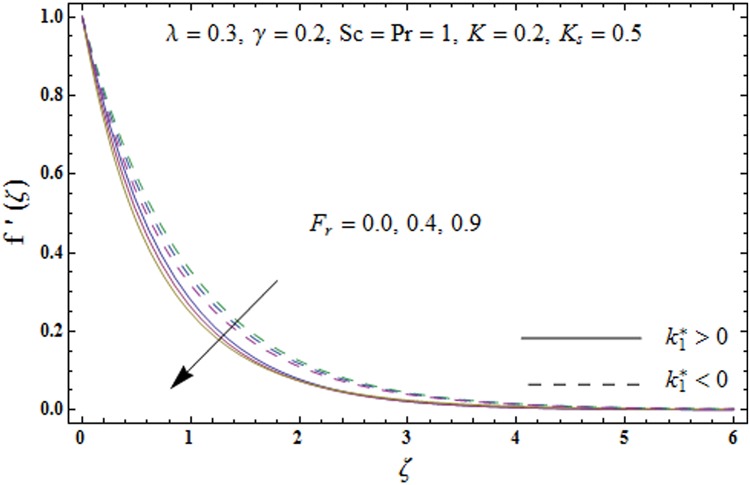
Plots of velocity field f'(ζ) for inertia coefficient Fr.